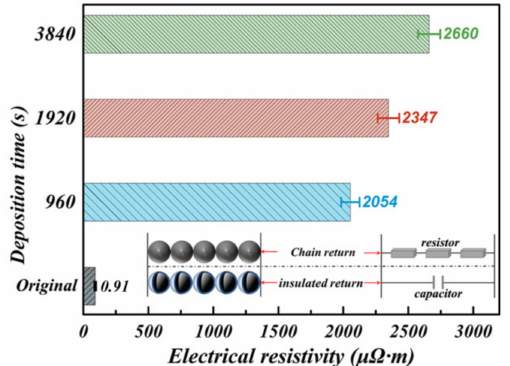
Figure 7. Electrical resistivities of the original Fe-6.5wt.%Si particles and Fe-6.5wt.%Si / SiO 2 C-S particles following deposition.